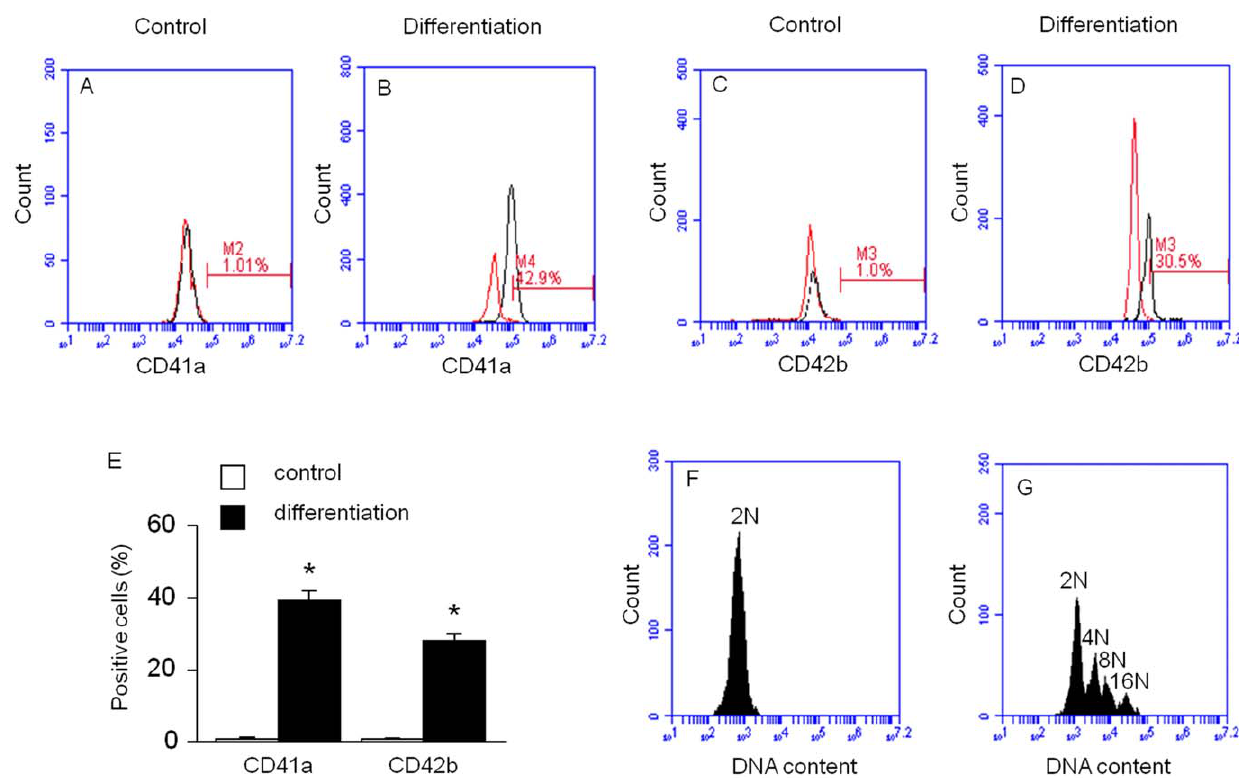
Figure 3. Flow cytometric analysis of MKs differentiated from hESSCs. Flow cytometric analysis of MK differentiation rate was determined by specific cell surface markers (A, B: CD41a; C, D: CD42b; left curves: isotype controls; right curves: antibodies). E, summarized data are expressed as mean 6 SEM, *P , 0.01, control versus differentiation, n=4/group. Analysis of DNA polyploidy of the MKs differentiated from hESSCs (F, control; G, MK differentiation).